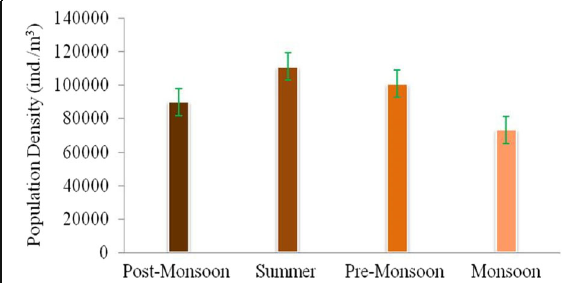
Fig. 4 Population density of zooplankton recorded in the Ukkadam Lake during December 2011 – November